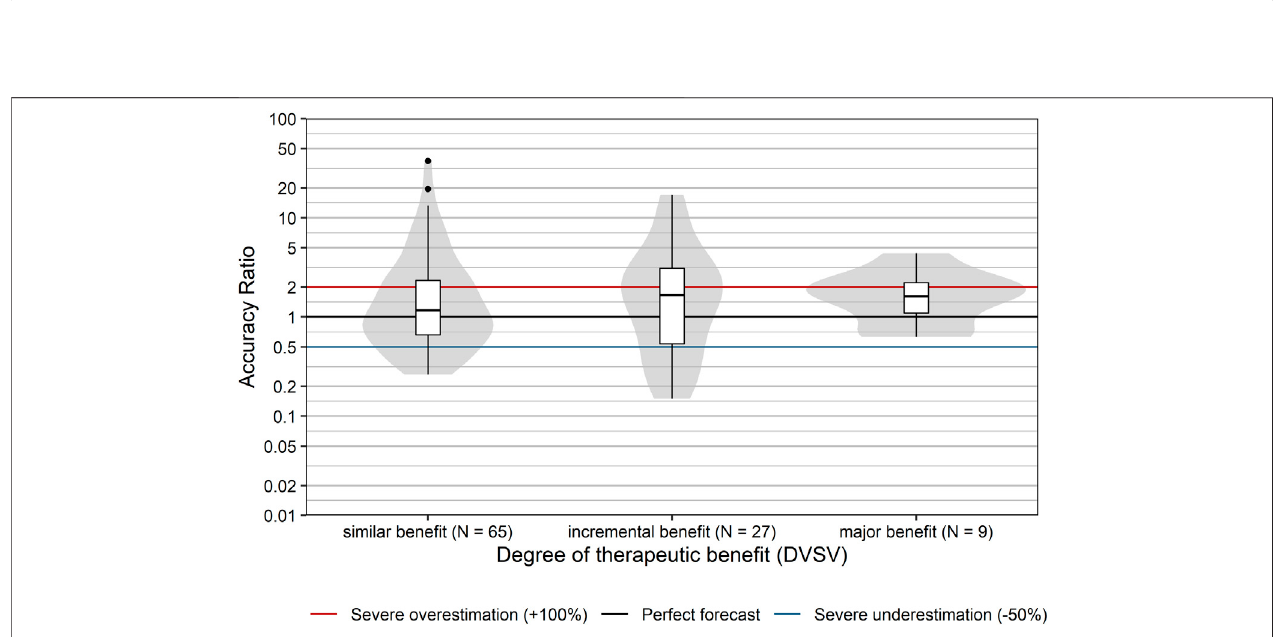
FIGURE7| Comparisonofaccuracyratiosbydegreeoftherapeuticbene fi t.Boxplotsandviolinplotsshowaccuracyratiosofforecastedsalesinthe3 yearsaftera positive reimbursement decision grouped by degree of therapeutic bene fi t as assessed by DVSV. Due to their asymmetric nature, accuracy ratios are plotted on a logarithmic (base 10) scale to avoid visually overemphasizing overestimates compared to underestimates.